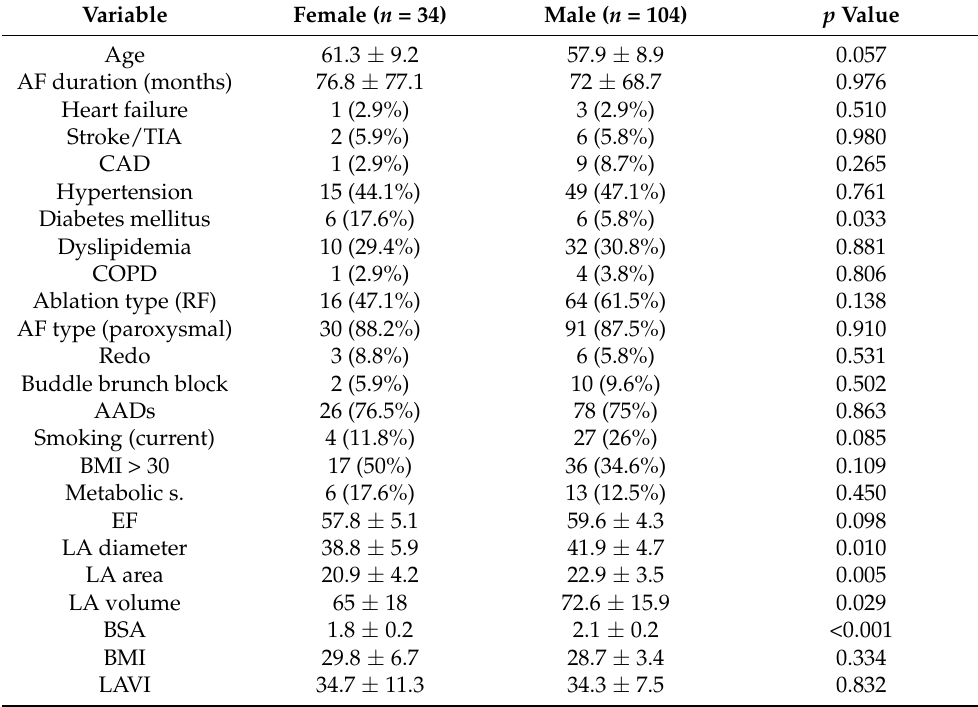
Table A1. Characteristics compared according to patient’s